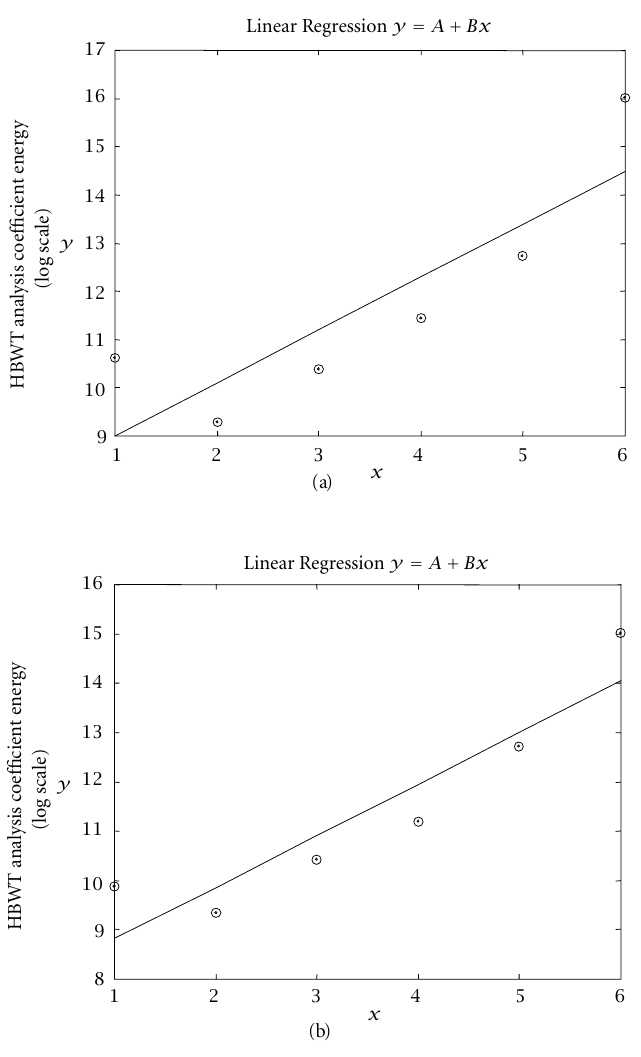
Figure 11: Trumpet: linear regression according to (33), (a) first harmonic left sideband, (b) right